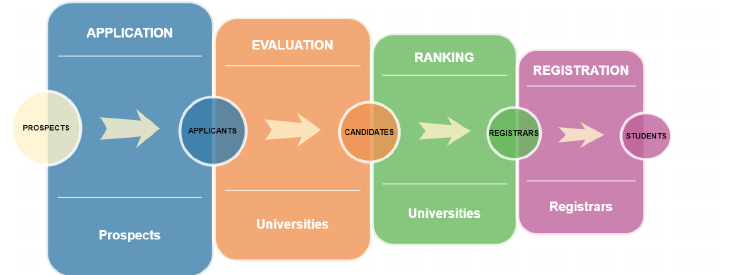
Figure 1. University admission